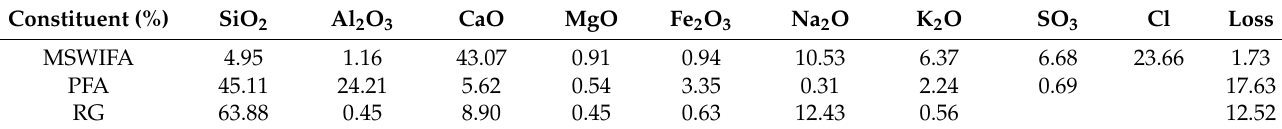
Figure 2. XRD patterns of raw materials (1-CaCO 3 (PDF#72-1653), 2-CaSO 4 (PDF#37-0184), 3- CaClOH (PDF#73-1885), 4-KCl (PDF#75-0298), 5-NaCl (PDF#88-2300), 6-SiO 2 (PDF#79-1906), 7-Mu- lite (PDF#84-1205)).